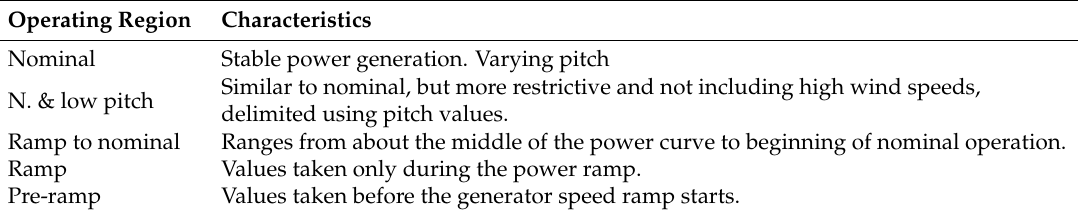
Table 2. Descriptions of the different operating